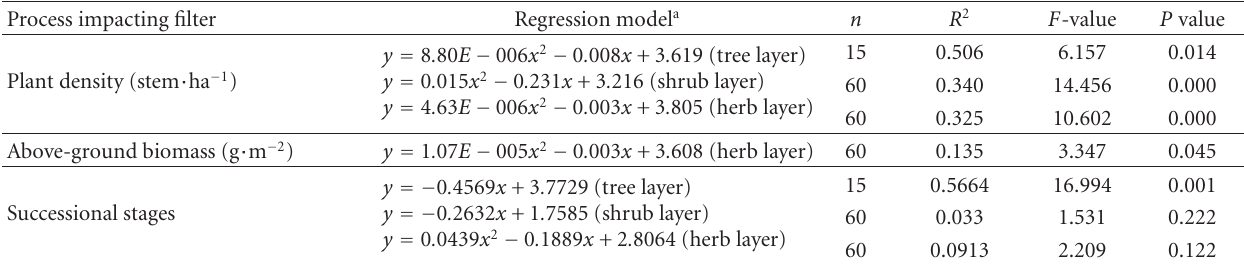
Table 5: The regression relationship between ln Y and, respectively, plant density, herb above-ground biomass, and successional stages at the plot